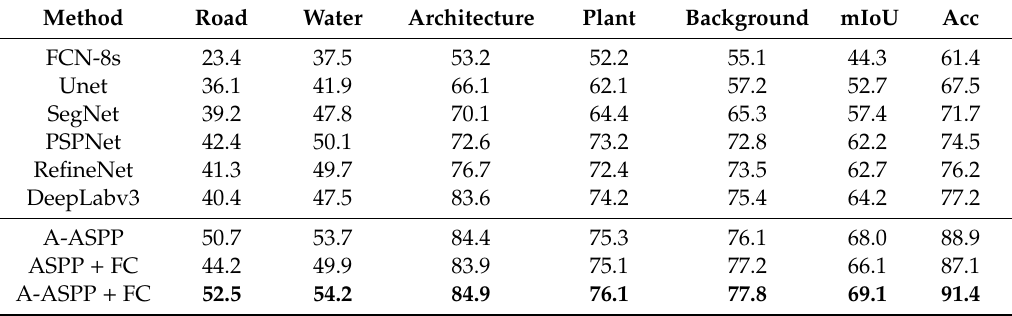
Table 3. Results on HRRS data in terms of mean IoU (mIou) and Acc. The best model performance is shown in